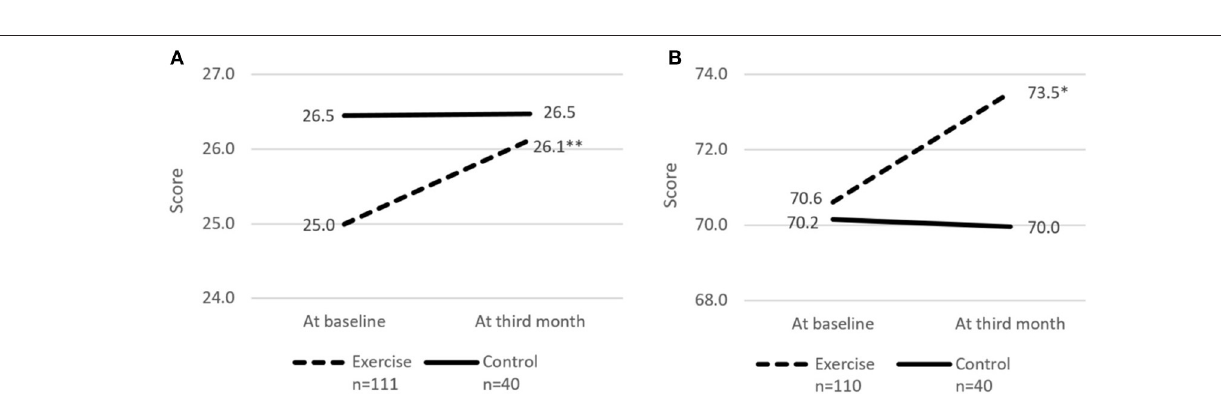
FIGURE 4 | Cognitive score and perceived health rating at baseline and third month. (A) cMMSE. (B) Perceived health rating. cMMSE, Chinese Mini-mental state examination. Perceived health rating derived from EuroQol - Visual Analog Scale. * and **indicates significant difference at p < 0.05 and p < 0.01, respectively between baseline and third month using paired sample t